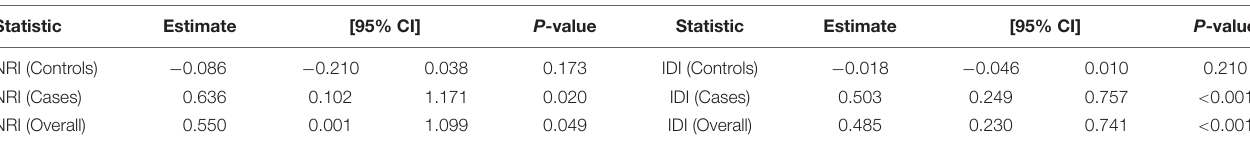
FIGURE 4 | Performance evaluation of internal validation cohort and external verification cohort on the PRIME score and verification of EuroSCORE II. (A) The area under the receiver operating characteristic (ROC) curves showed that the area under the curve (AUC) of all-cause death in the internal validation cohort of the PRIME score was 0.9021 (95% confidence interval [CI]: 0.8487–0.9555), which was better than that of EuroSCORE II ( P = 0.0011). (B) The area under the ROC curve showed that the prime score with AUC of 0.8730 (95% CI: 0.7690–0.9770) in the external validation cohort was also better than EuroSCORE II ( P = 0.0062). TABLE 3 | Improved model performance over the EuroSCORE